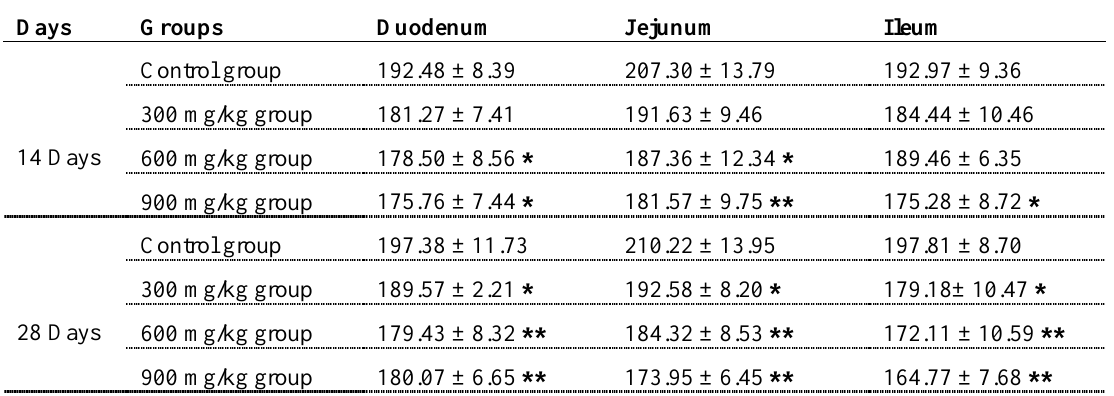
Table 4. Change of the ability to inhibit hydroxy radical (U/mgprot) in the intestinal mucosa. Days Groups Duodenum